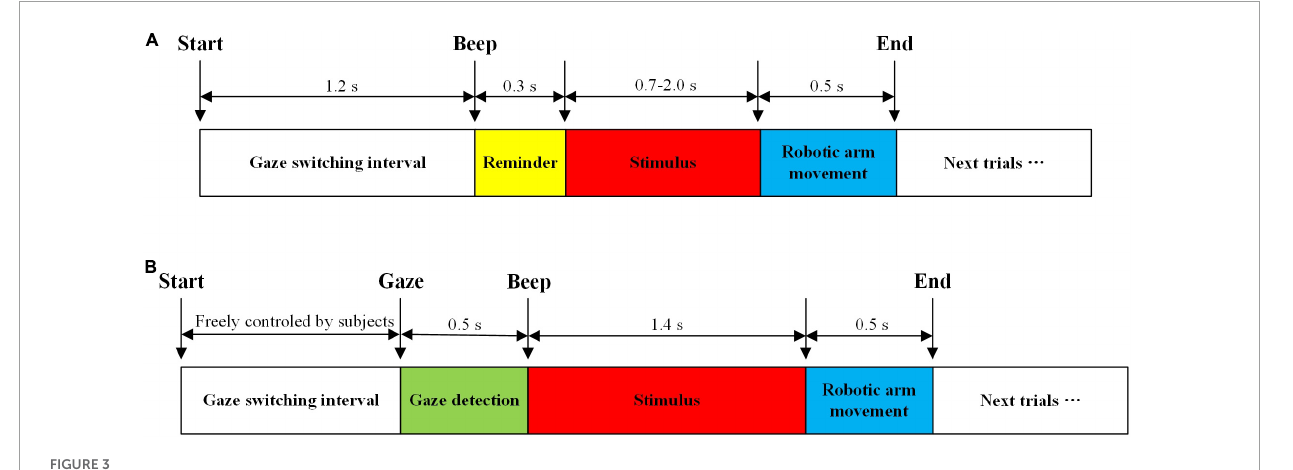
FIGURE3 Implementation procedure. (A) Simultaneous mode. (B) Sequential